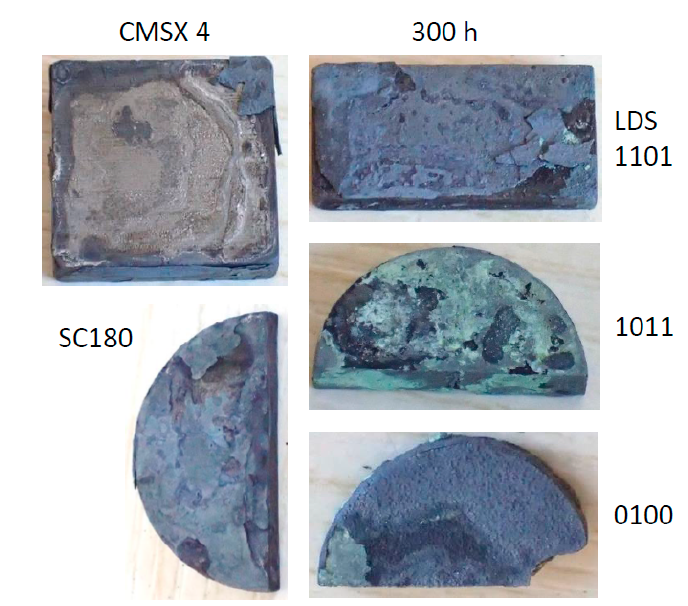
Figure 6. Macrographs showing visual appearance of aggressive attack and spallation for corroded CMSX-4, SC180, and three LDS alloys after 300 h.